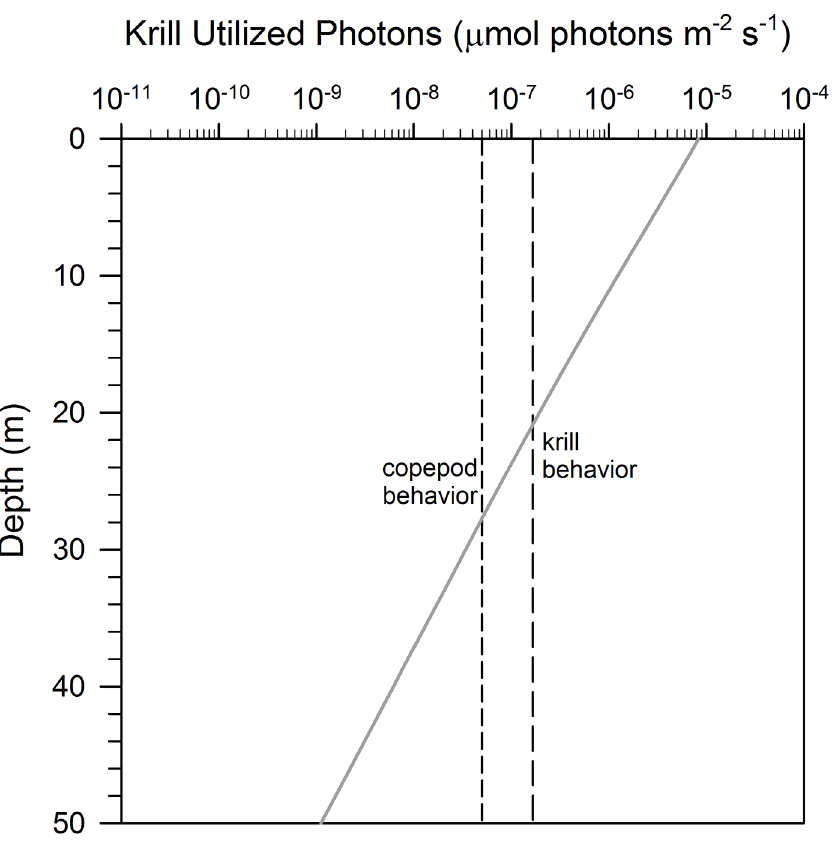
Fig 4. Spectrally-integrated midday light in Kongsfjorden as related to zooplankton thresholds for light-mediated behavior. Spectrally-integrated irradiance as krill-utilized photons is plotted as a function of depth (grey line). Lower visual thresholds determined behaviorally in previous studies with blue broadband light are plotted as vertical lines for krill Meganyctiphanes norvegica (krill behavior, medium dash, Myslinksi et al. 2005) and copepods Calanus spp. (copepod behavior, short dash, B å tnes et al.